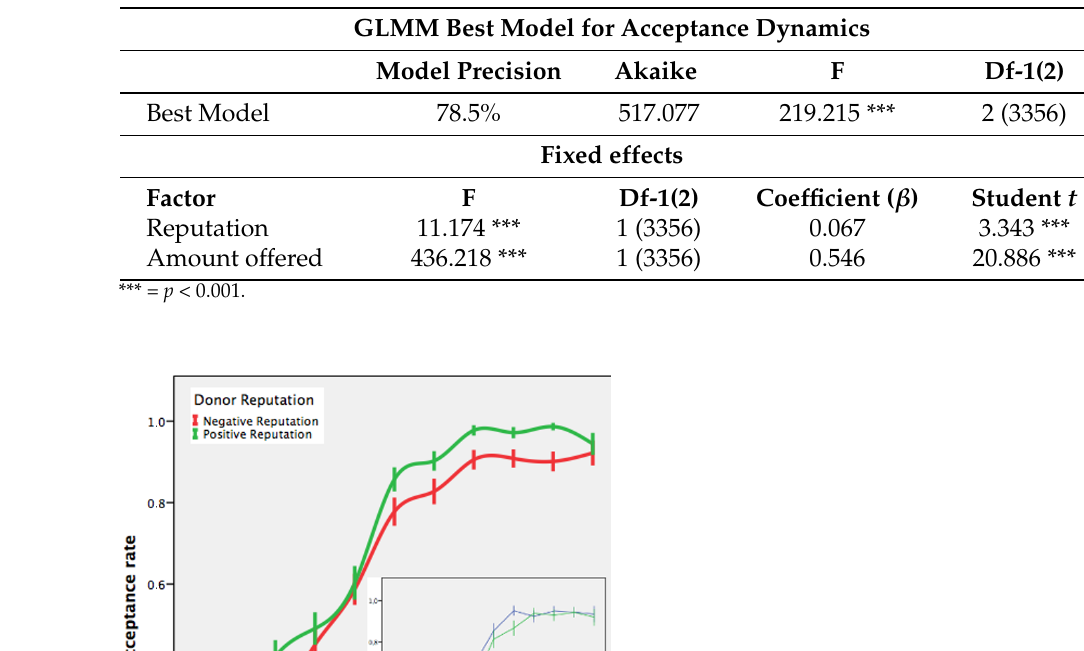
Table 3. Generalized Linear Mixed Models 1. Acceptance dynamics.